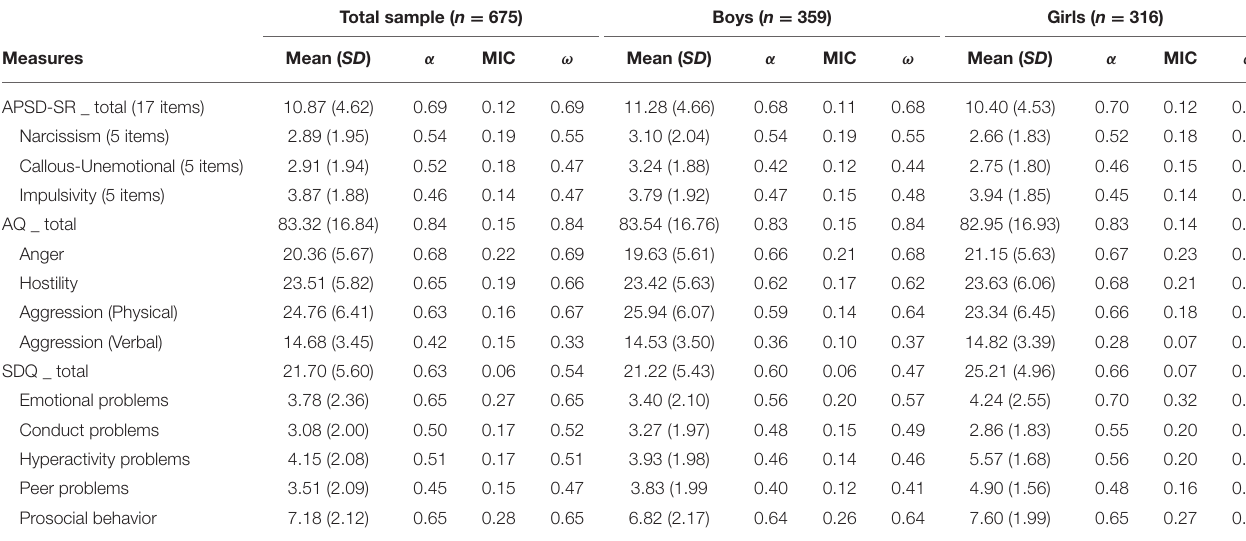
TABLE 1 | Descriptive statistics of APSD-SR, AQ, and SDQ. Total sample ( n = 675) Boys ( n = 359) Girls ( n =